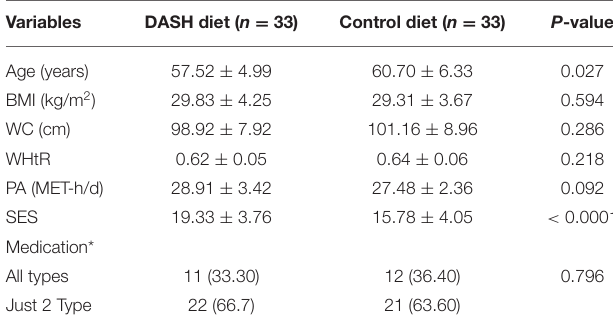
TABLE 2 | Baseline characteristics of women with type 2